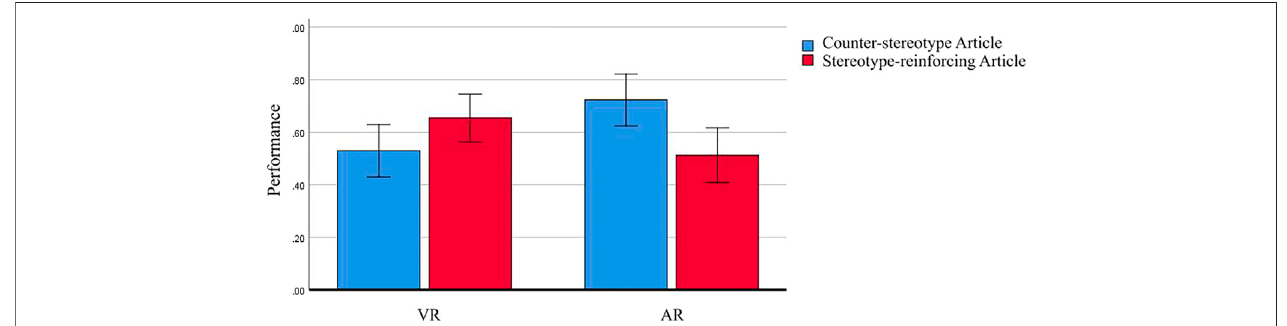
FIGURE 1 | Impact of stereotype threat prompt article and modality on performance (means and con fi dence intervals).